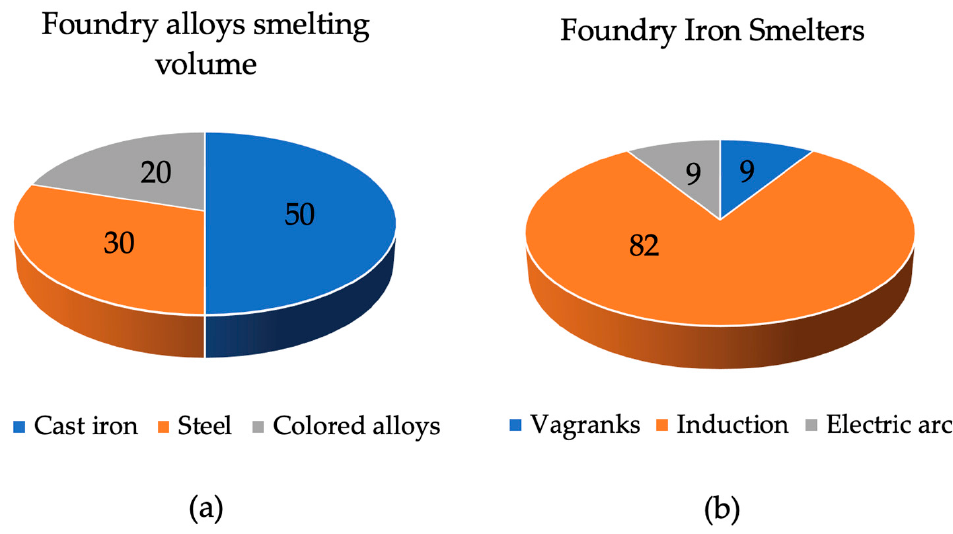
Figure 1. Distribution of foundries: ( a ) foundry alloy smelting volume; ( b ) foundry iron smelters.